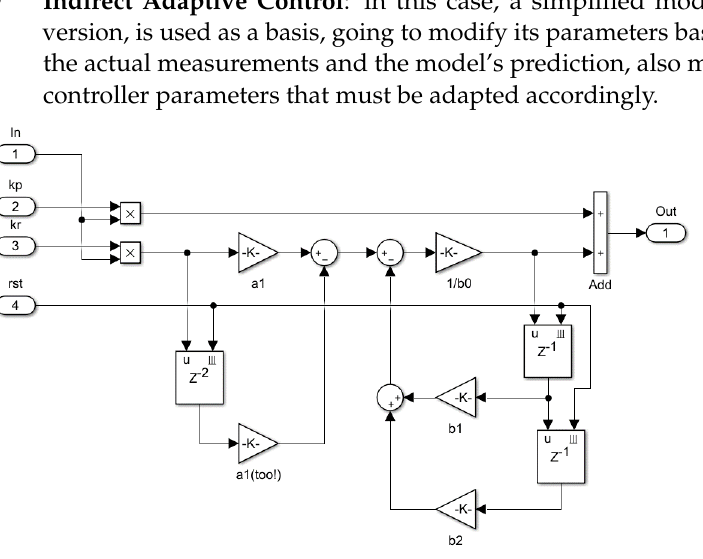
Figure 19. Proportional resonant controller implementation example.